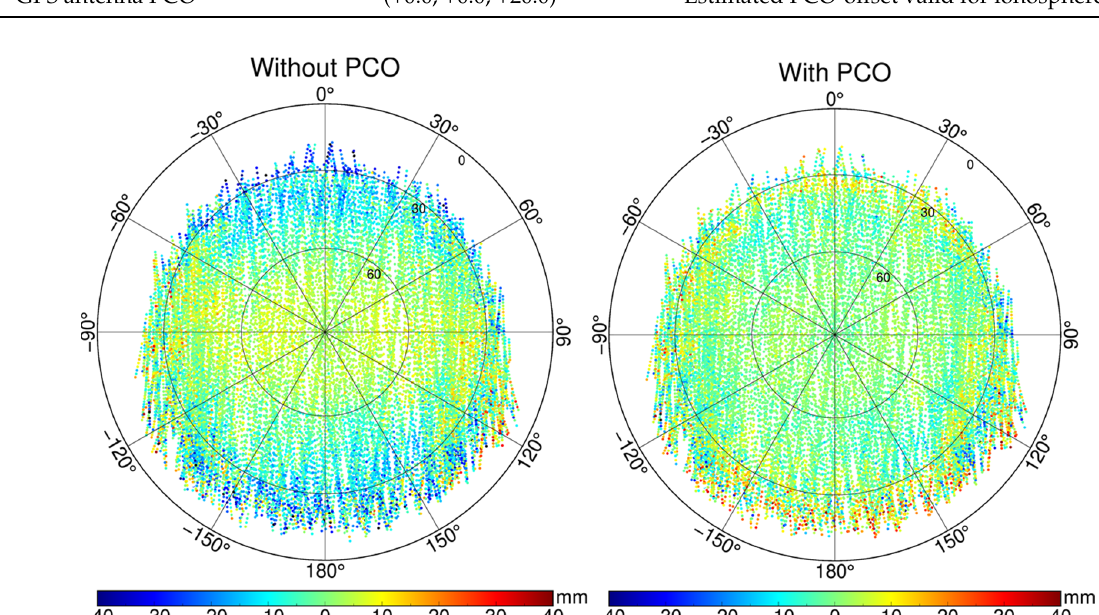
Figure 6. Sky plot of the residuals of the ionosphere-free L1/L2 carrier phase combination for HY-2B on 1 January 2019. The azimuth 0° of the antenna frame coincides with the +x-axis of the spacecraft’s body, which points into the flight direction.